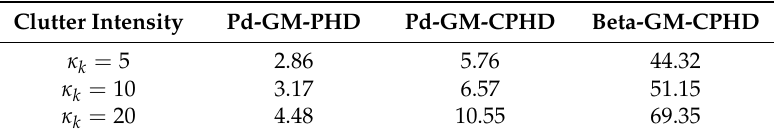
Table 5. The average running time when tracking four targets